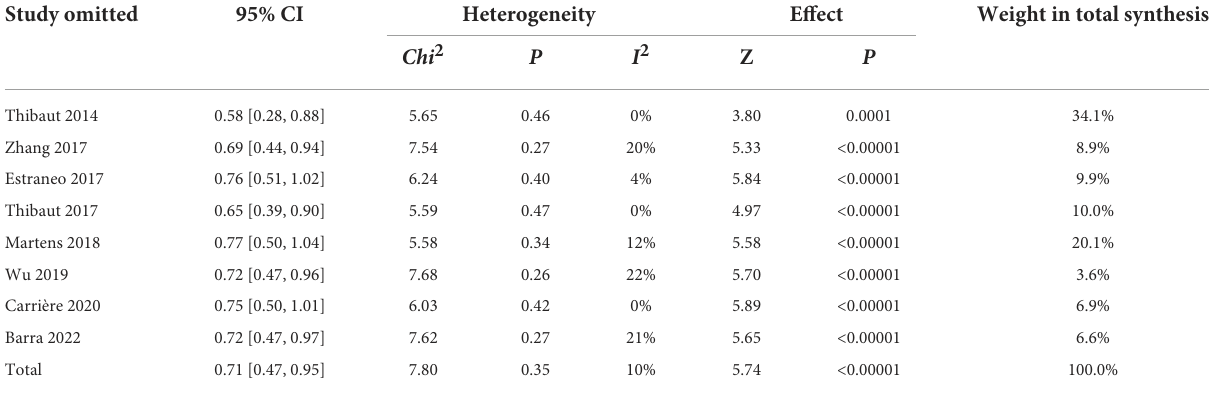
TABLE 2 Summary of leave-one-out sensitivity analysis for total studies included in quantitative synthesis ( n = 8). Study omitted Effect Weight in total